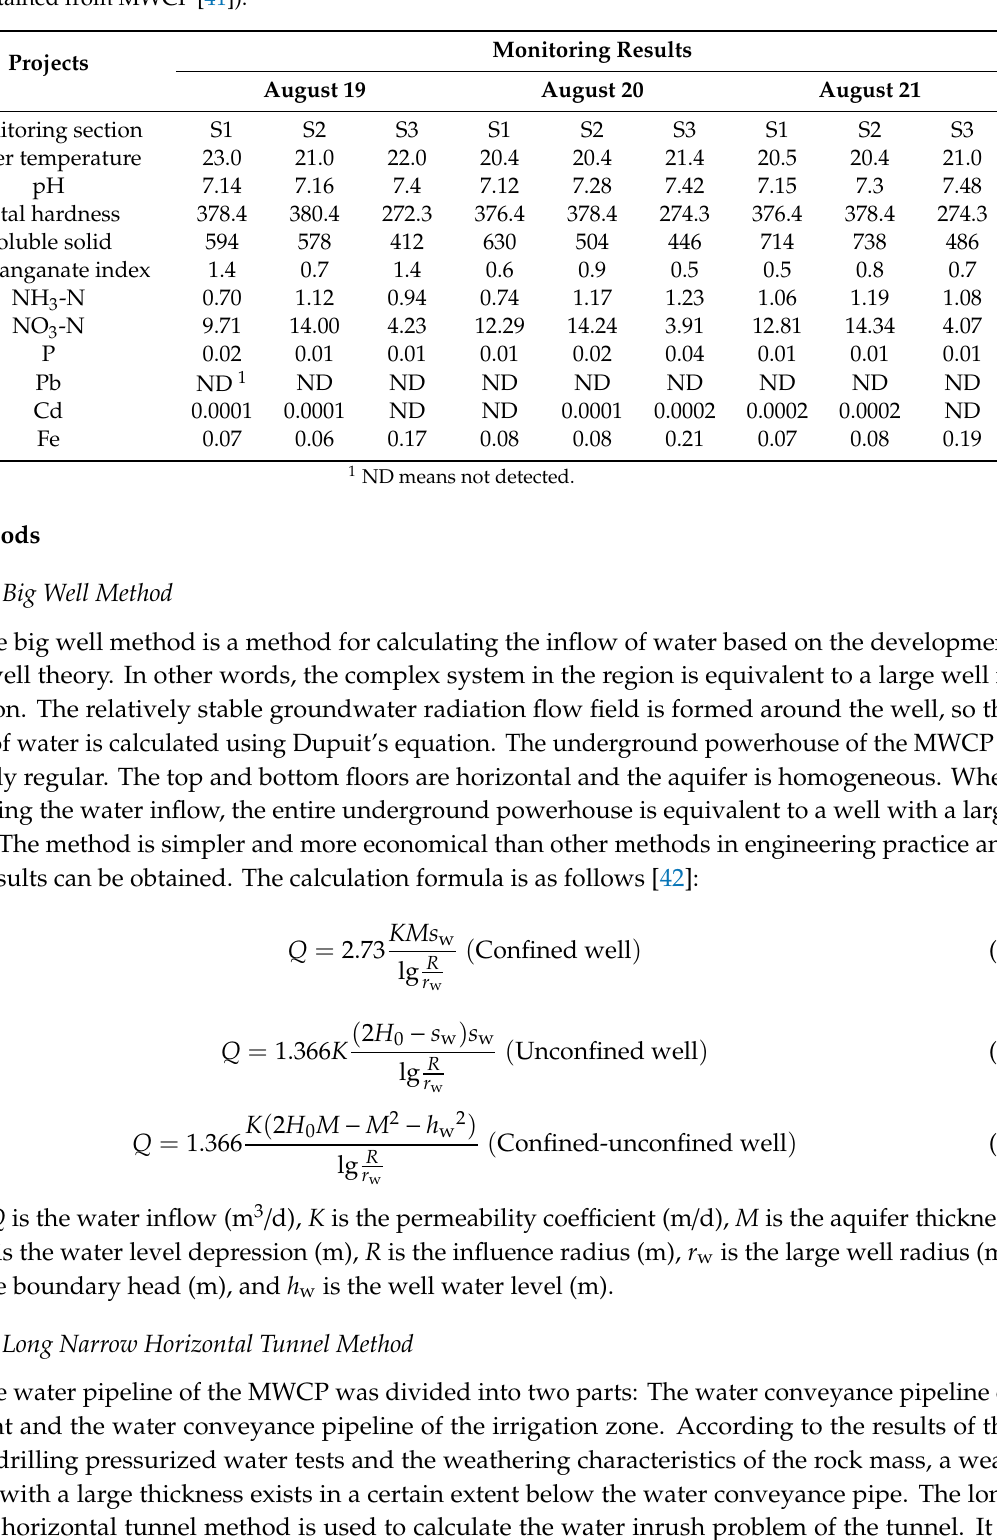
Table 4. Groundwater quality monitoring results (mg / L, water temperature ( ◦ C), pH is dimensionless) (obtained from MWCP